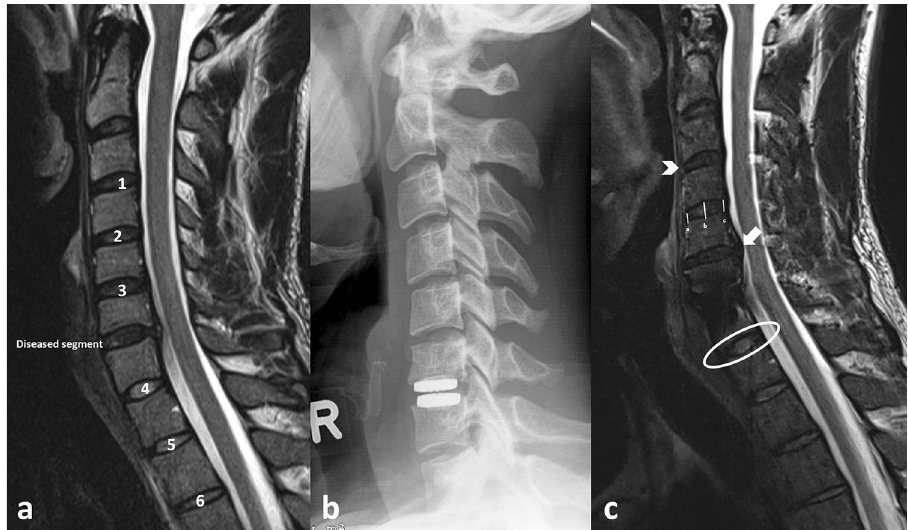
Figure 1. MRI evaluation and SDI measurements. ( a ) Preoperative MRI scan, 1 = Distal cranial adjoining segment, 2 = Proximal cranial adjoining segment, 3 = Cranial adjacent segment, 4 = Caudal adjacent segment, 5 = Proximal caudal adjoining segment, 6 = Distal caudal adjoining segment ( b ) Postoperative radiograph after CDA implantation. ( c ) Follow-up MRI scan, white arrow head = no anterior disc protrusion (0 point), a = anterior disc height, b = middle disc height, c = posterior disc height, white arrow = disc material protruding behind the margin of the vertebral body (1 point), white ring = disc signal intensity (Bright as or slightly less bright than CSF—0